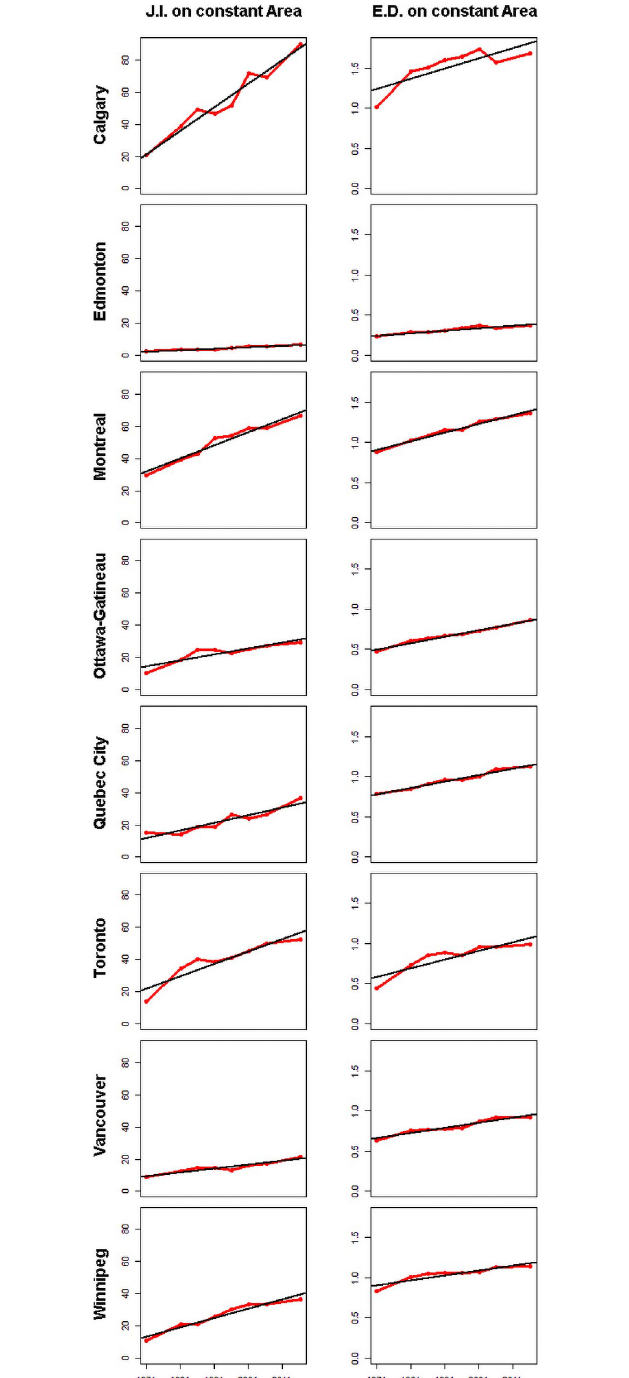
Fig 5. Diagrams showing fragments and fragmentation indexes for Canada’s eight largest CMAs. The first and second columns show results from two fragmentation indices on a constant area over time—the Johnsson fragmentation index (F.I. on constant area) and Edge Density (E.D. on a constant area). Johnsson Fragmentation Index values were multiplied by a million. Confidence intervals from bootstrapping are available in the supplementary material (S8) in S1 Appendix. Every panel in this figure has significant trends at an α = 0.05.